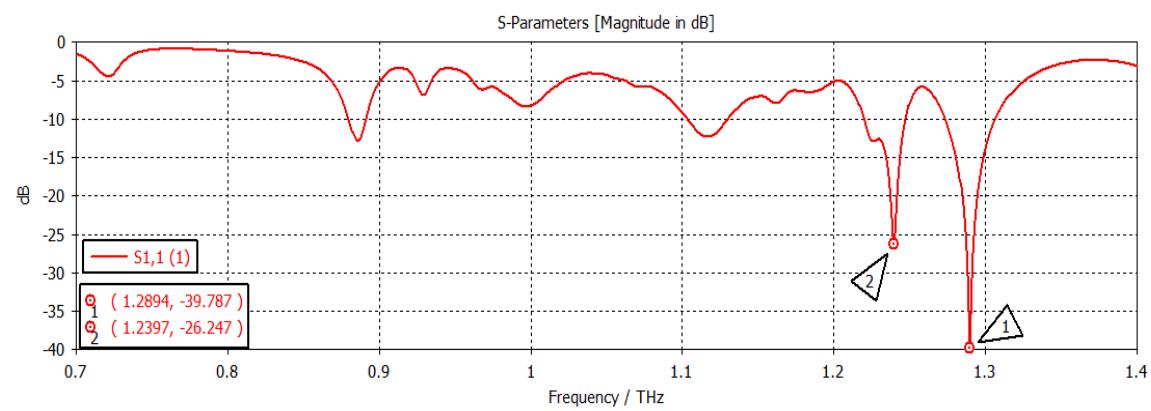
Figure 8. Chemical potential = 0.4 eV.